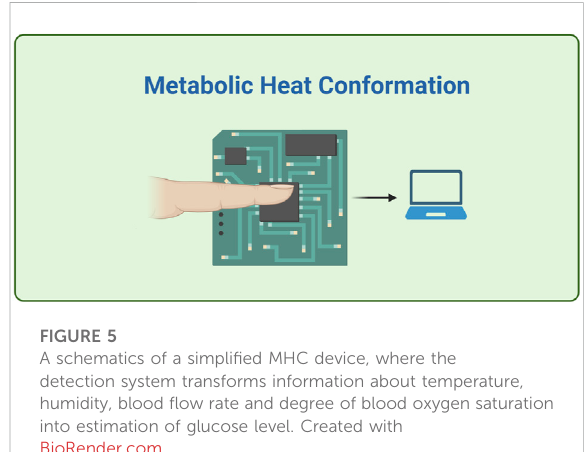
FIGURE 5 A schematics of a simpli fi ed MHC device, where the detection system transforms information about temperature, humidity, blood fl ow rate and degree of blood oxygen saturation into estimation of glucose level. Created with